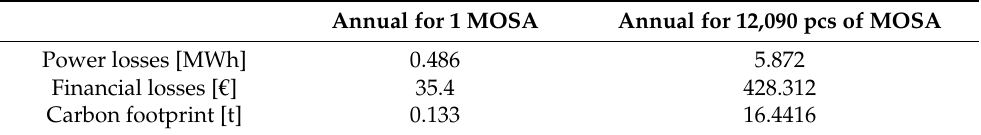
Table 1. Annual losses due to faulty surge arresters in the Slovenian distribution